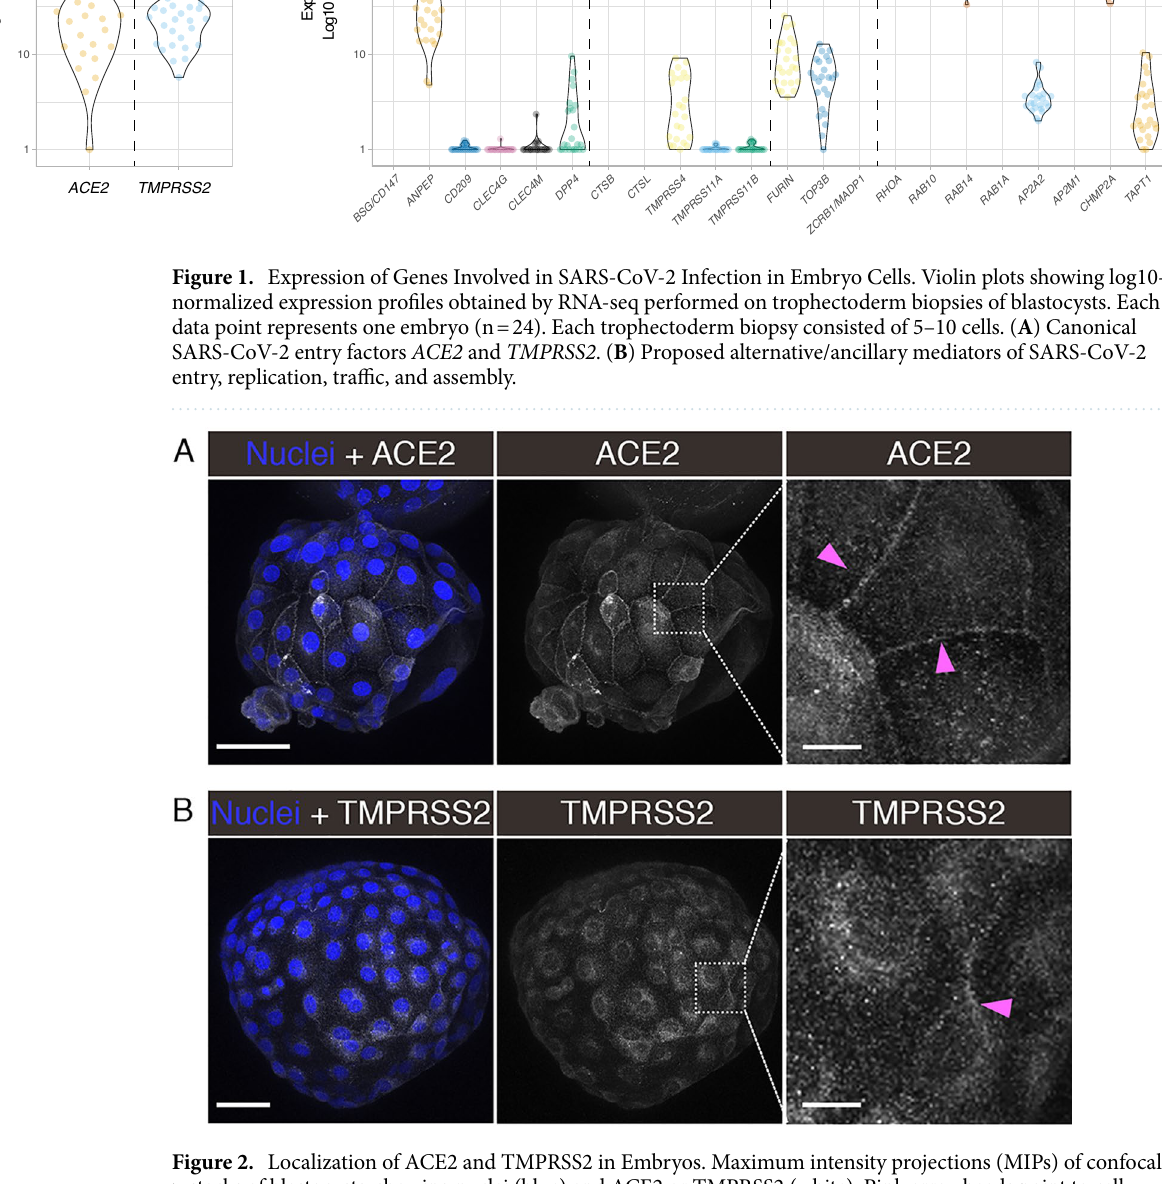
Figure 2. Localization of ACE2 and TMPRSS2 in Embryos. Maximum intensity projections (MIPs) of confocal z-stacks of blastocysts, showing nuclei (blue) and ACE2 or TMPRSS2 (white). Pink arrowheads point to cell membranes. Scale bars represent 50 µm in low magnification panels, and 10 µm in high magnification panels. Representative images from independent biological replicates (n = 5 embryos for each